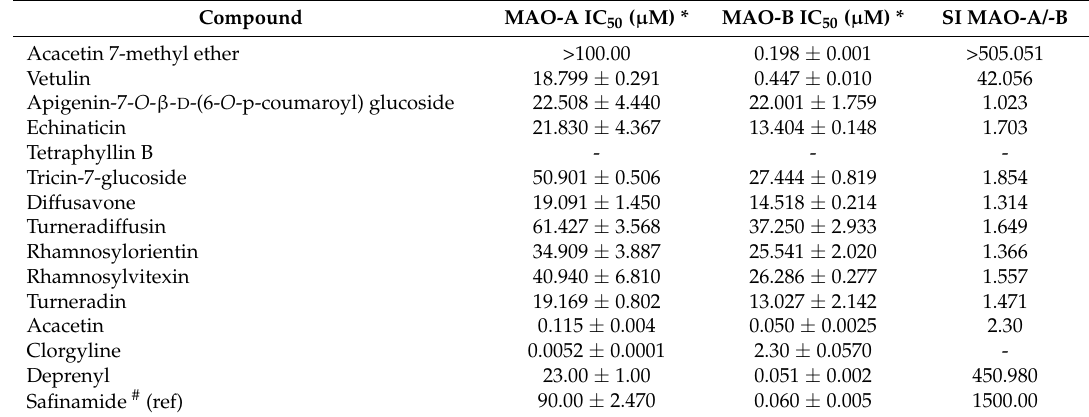
Table 1. Inhibition of recombinant human Monoamine Amine Oxidase-A and -B by constituents from T. diffusa .